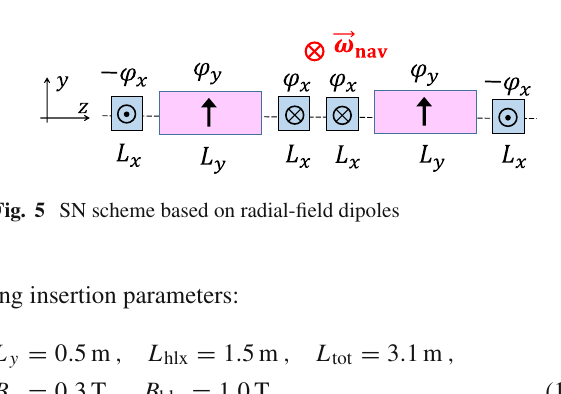
ing insertion parameters: